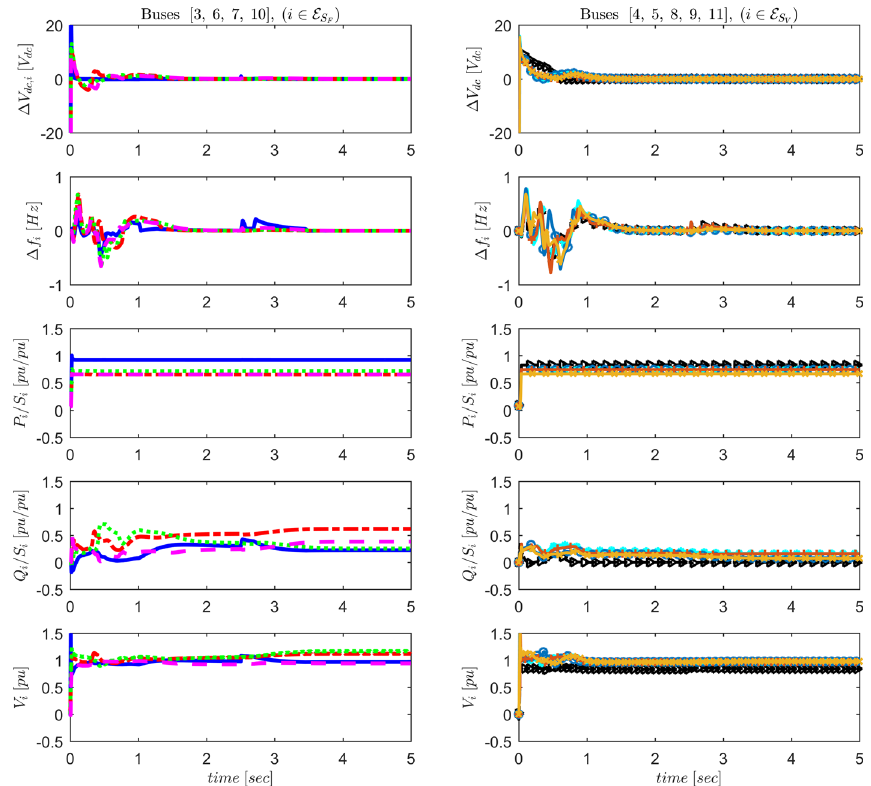
Fig. 13 Transition between grid-connected and islanded modes. The switching between grid-connected and islanded modes is occurred at time 2.5 sec . The microsource dynamic responses including dc voltage tracking, frequency synchronization, the power sharing as well as ac voltage tracking (amplitudes at output terminals). The lines correspond to the microsources at: bus 3, ’–’, bus 6, ’- -’, bus 7, ’..’, bus 10, ’-.’. Moreover, the lines correspond to other microsources at: bus 4, ’ > -’, bus 5, ’+-’, bus 8, ’x-’, bus 9, ’o-’, bus